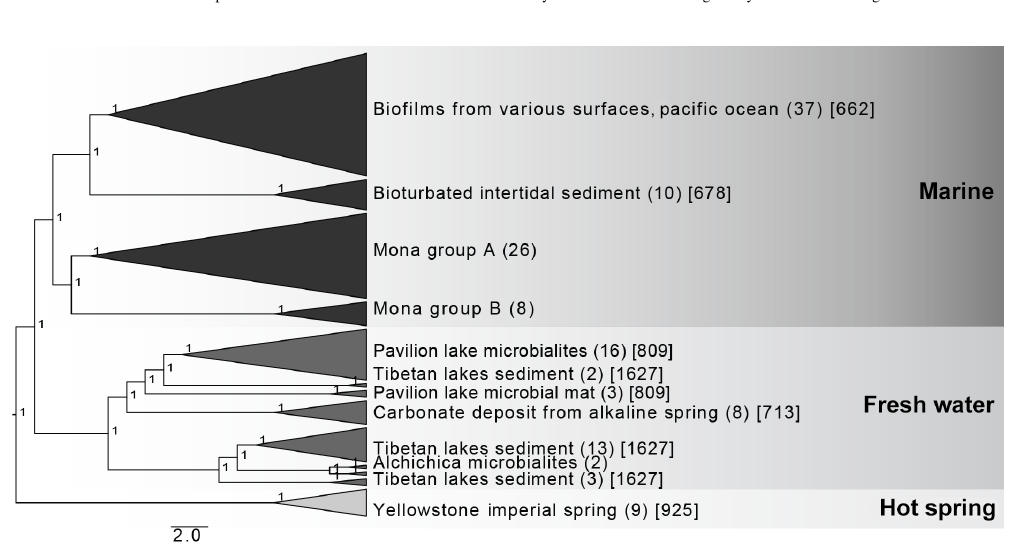
Figure 3. Hierarchical clustering analysis (UPGMA) of bacterial community composition in various settings based on pairwise Bray–Curtis distance metrics. The robustness of the topology was assessed through jackknife repeated resampling of 5000 sequences. The number of samples in a given collapsed tree branch are in parentheses, while the numbers in brackets are the Qiita dataset ID